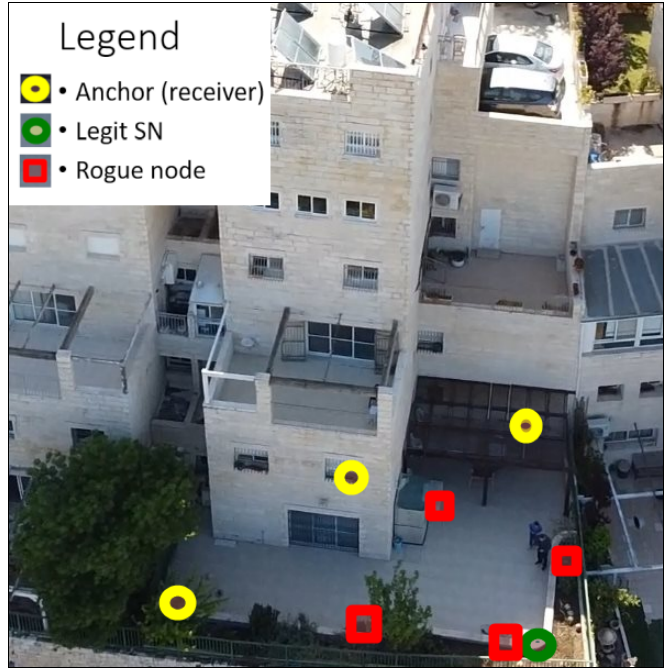
Figure 7. Photography of the live setup of the experiment, taken from the airborne rogue node.